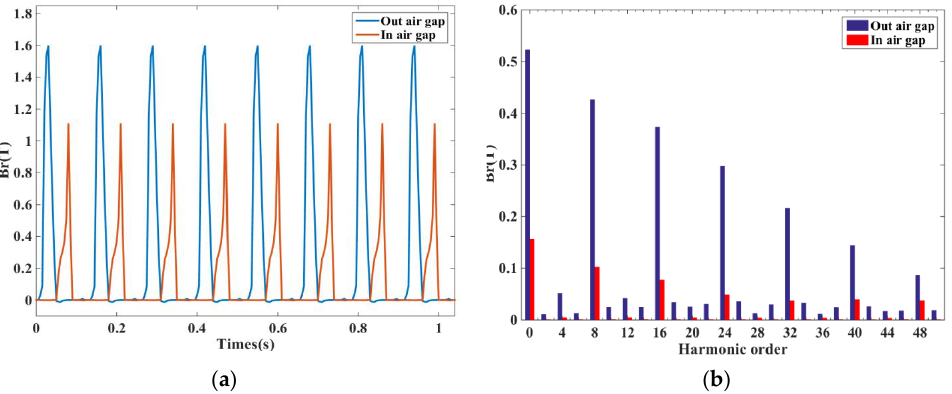
Figure 10. Radial magnetic density – rotor position – time waveform of external air gap of DDSRG.